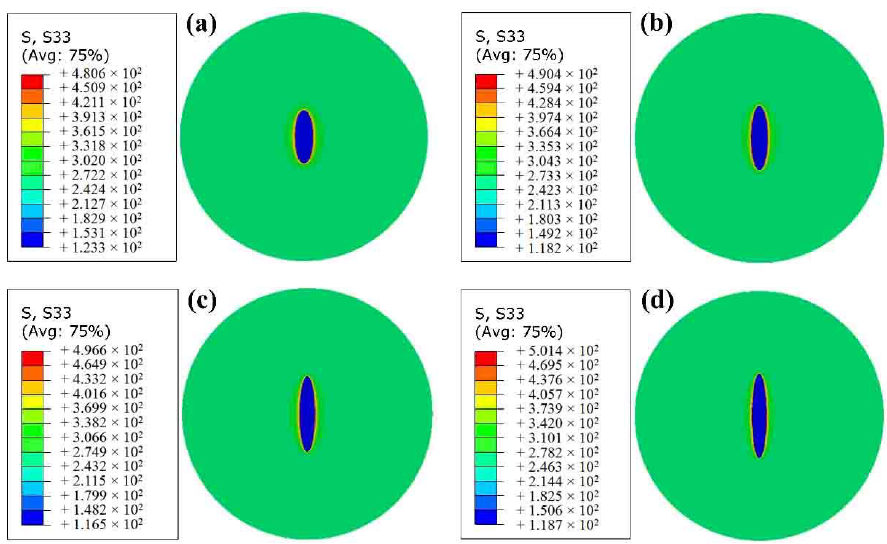
Figure 12. Stress distribution of the finite element models with different axial ratios (ARs) of elliptical MnS inclusion: ( a ) AR = 3, long axis of 170 μm; ( b ) AR = 4, long axis of 207 μm; ( c ) AR = 5, long axis of 240 μm; ( d ) AR = 6, long axis of 271 μm.